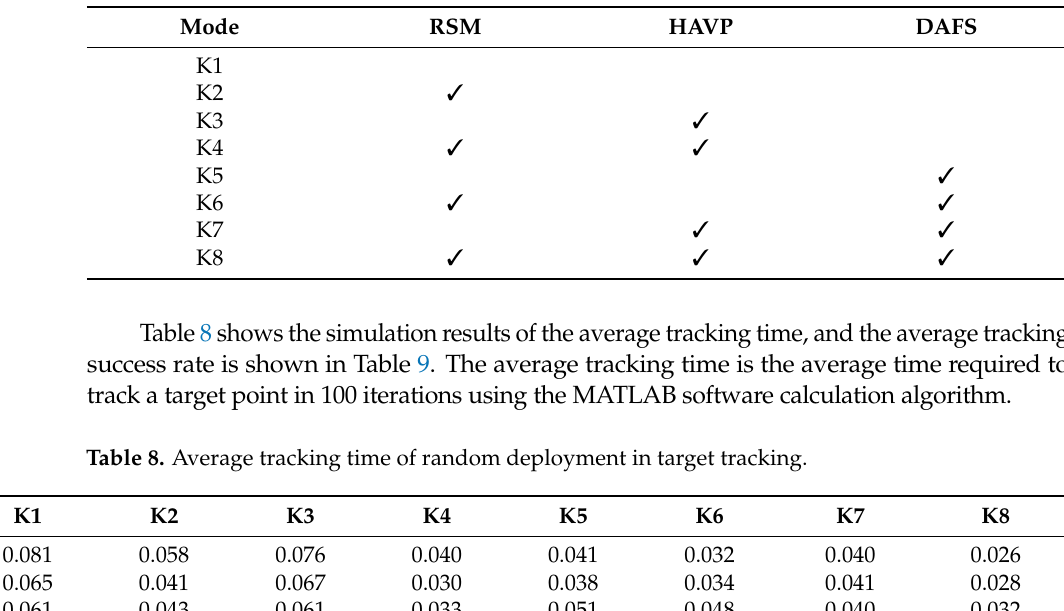
Table 7. Analysis modes for target tracking method.